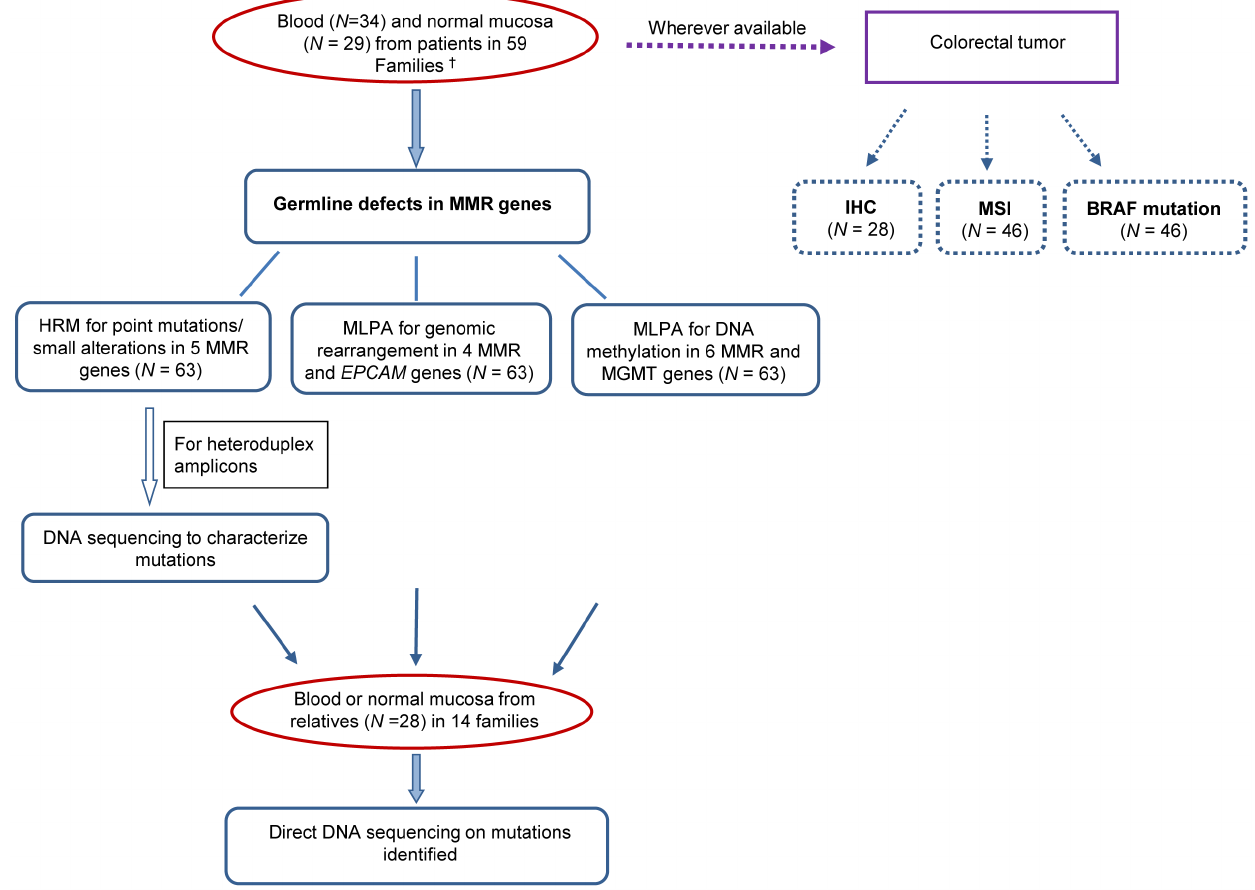
Figure 1. Flow diagram of the analytical strategy. Fifty nine unrelated families were screened for genetic defects in common MMR genes with all tests performed in parallel without using any sets of results for subsequent assays. Germline gene status was investigated by utilizing DNA extracted from blood or normal mucosa. Additional analyses in tumor tissues, such as immunohistochemical (IHC) assessment, microsatellite instability (MSI) test and mutation detection of BRAF V600E were performed where tumor materials were available. When a pathogenic or suspected deleterious defect was identified, family relatives were screened for presence of the same defect. { , at least one CRC patient each from 59 unrelated families.